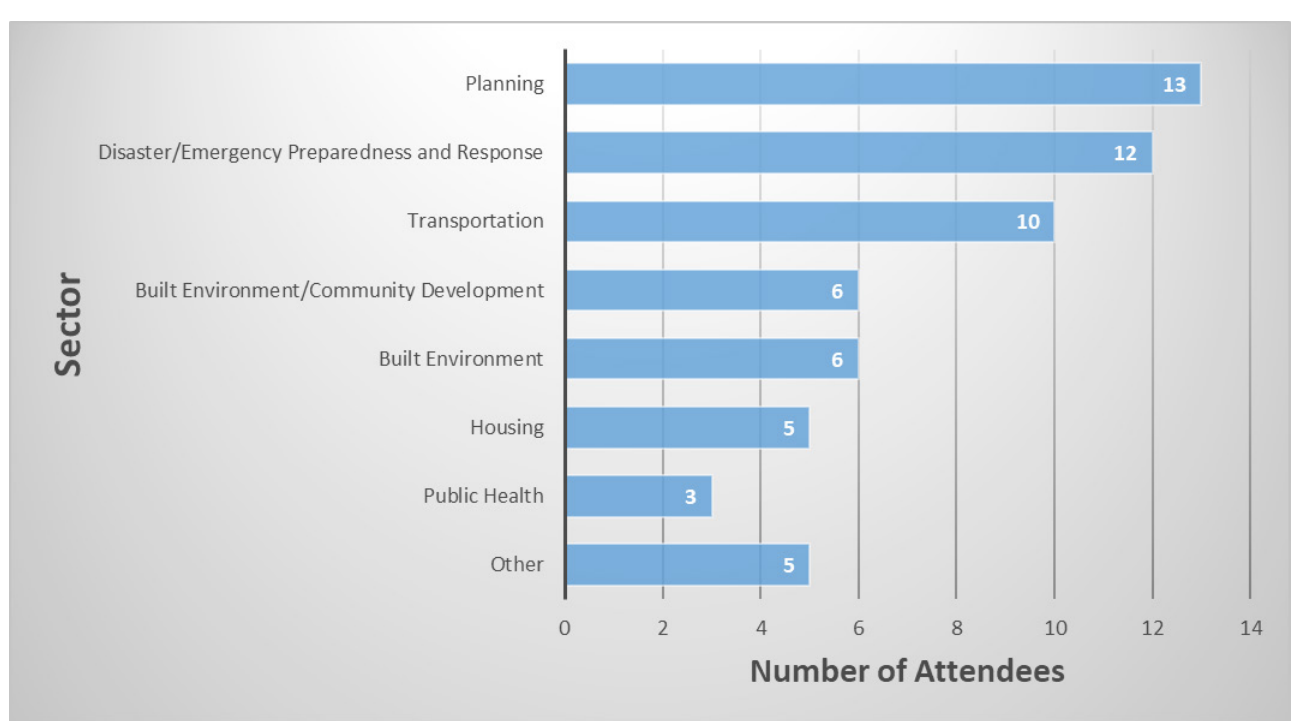
Figure 3. Sector Representation of Focus Group